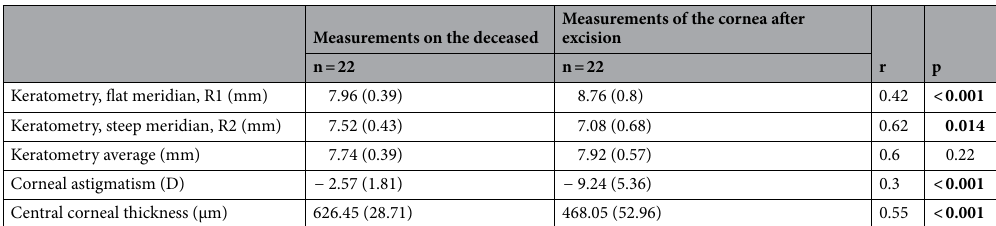
Table 3. Comparison of the curvature of the anterior surface of the cornea between the cornea measured on the deceased and the cornea measured after its removal from the eye; mean (± SD); r—Pearson’s correlation coefficient. Significant values are in